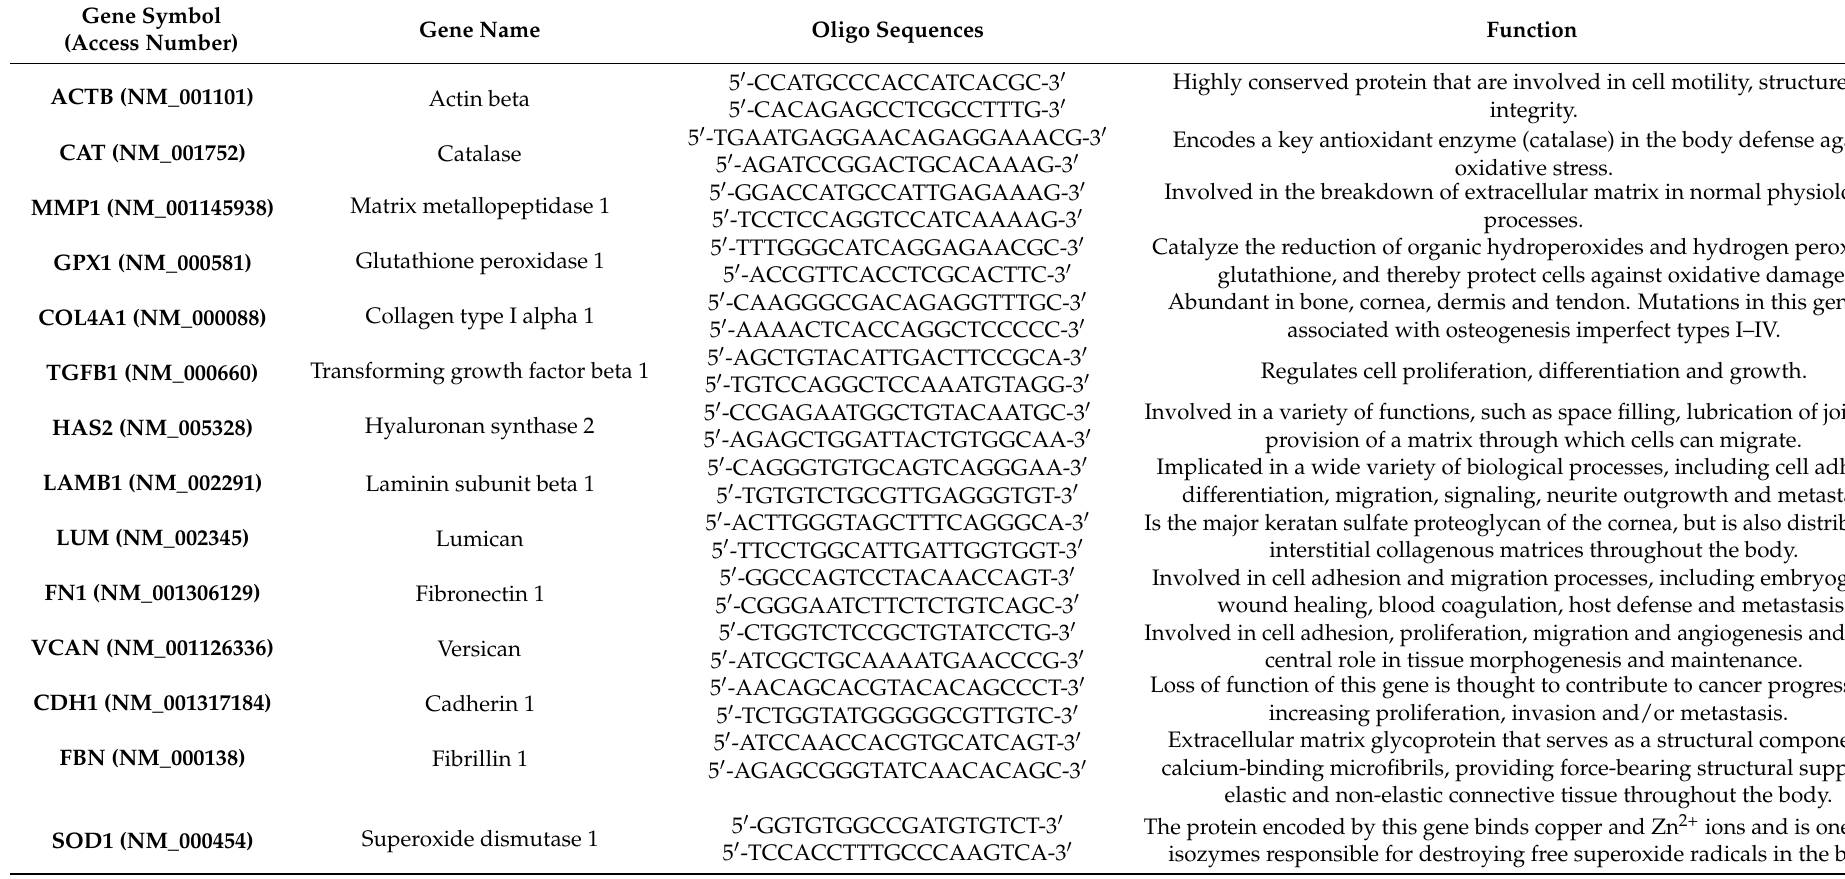
Table 1. Details of specific genes used in the RT-qPCR